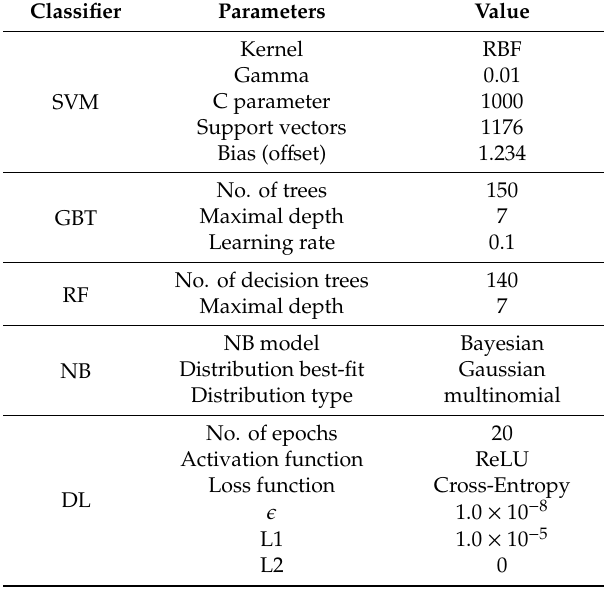
Table 3. The parameters of the comparison